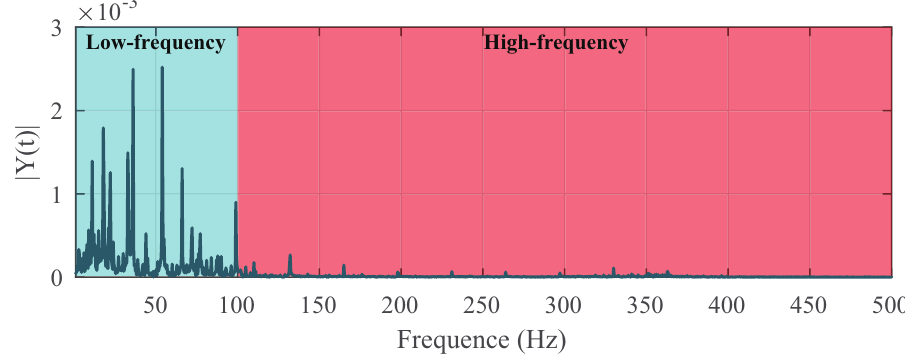
Figure 8. The FFT spectrum of tracking